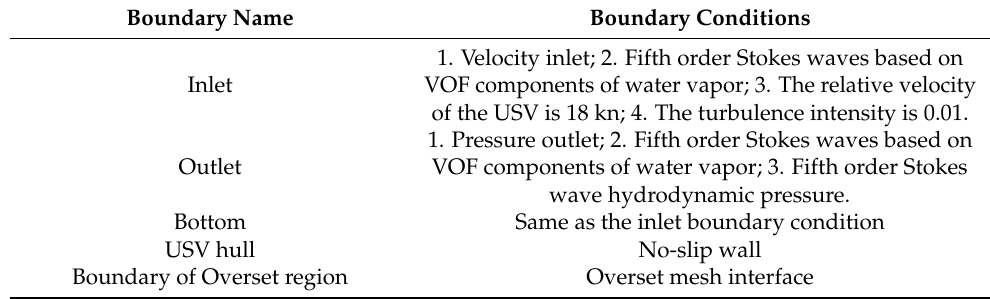
Table 2. Boundary conditions.